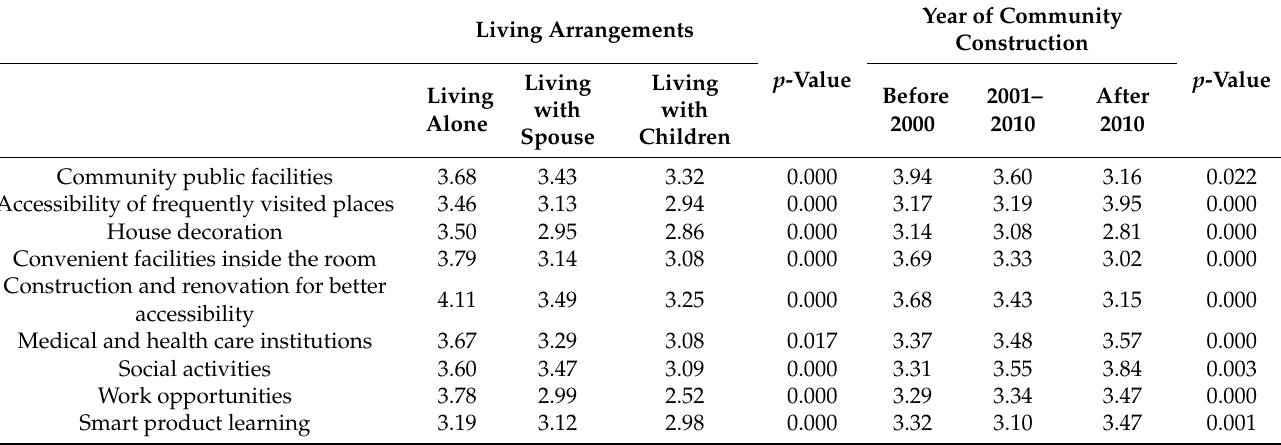
Table 12. Results of the Kruskal–Wallis test for different